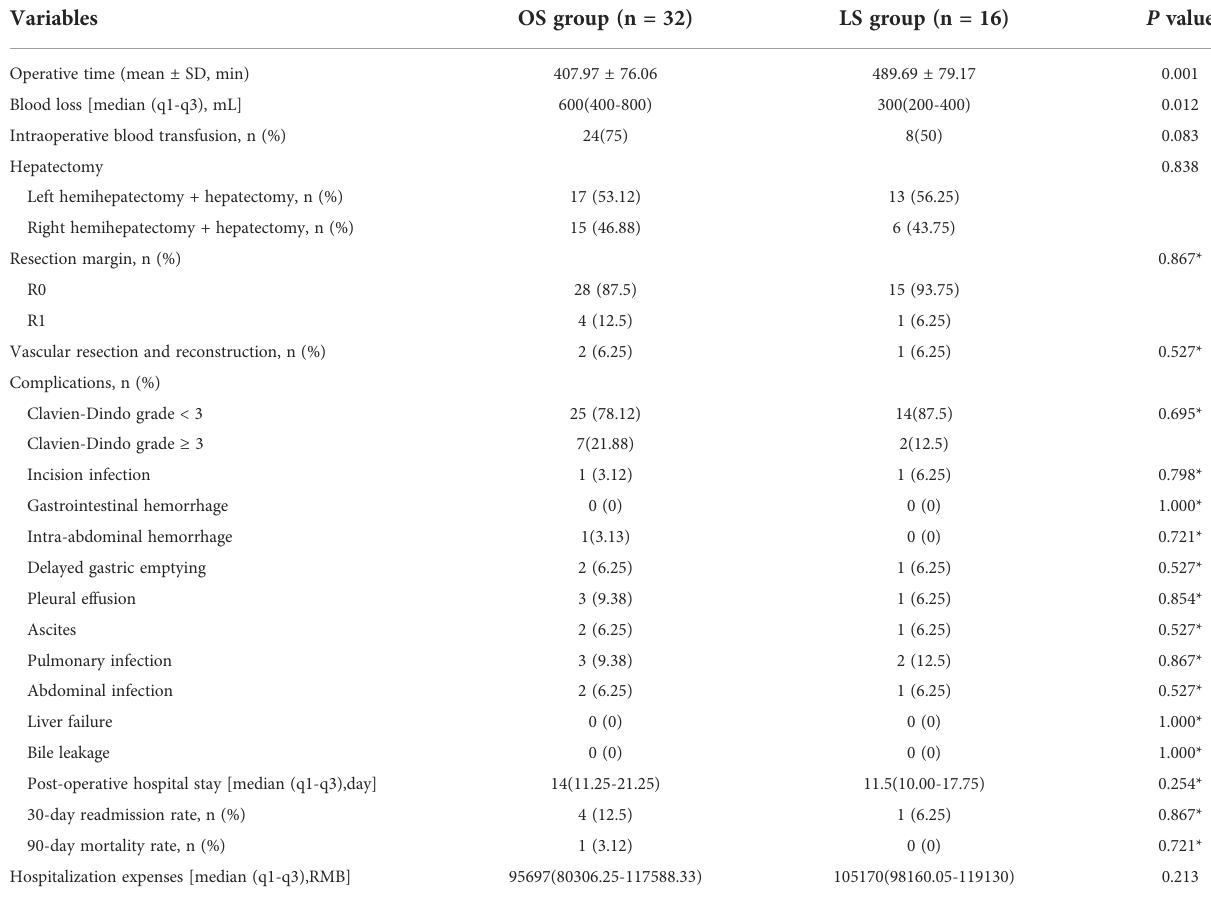
TABLE 3 Intraoperative data and surgical effectiveness in the OS and LS groups.